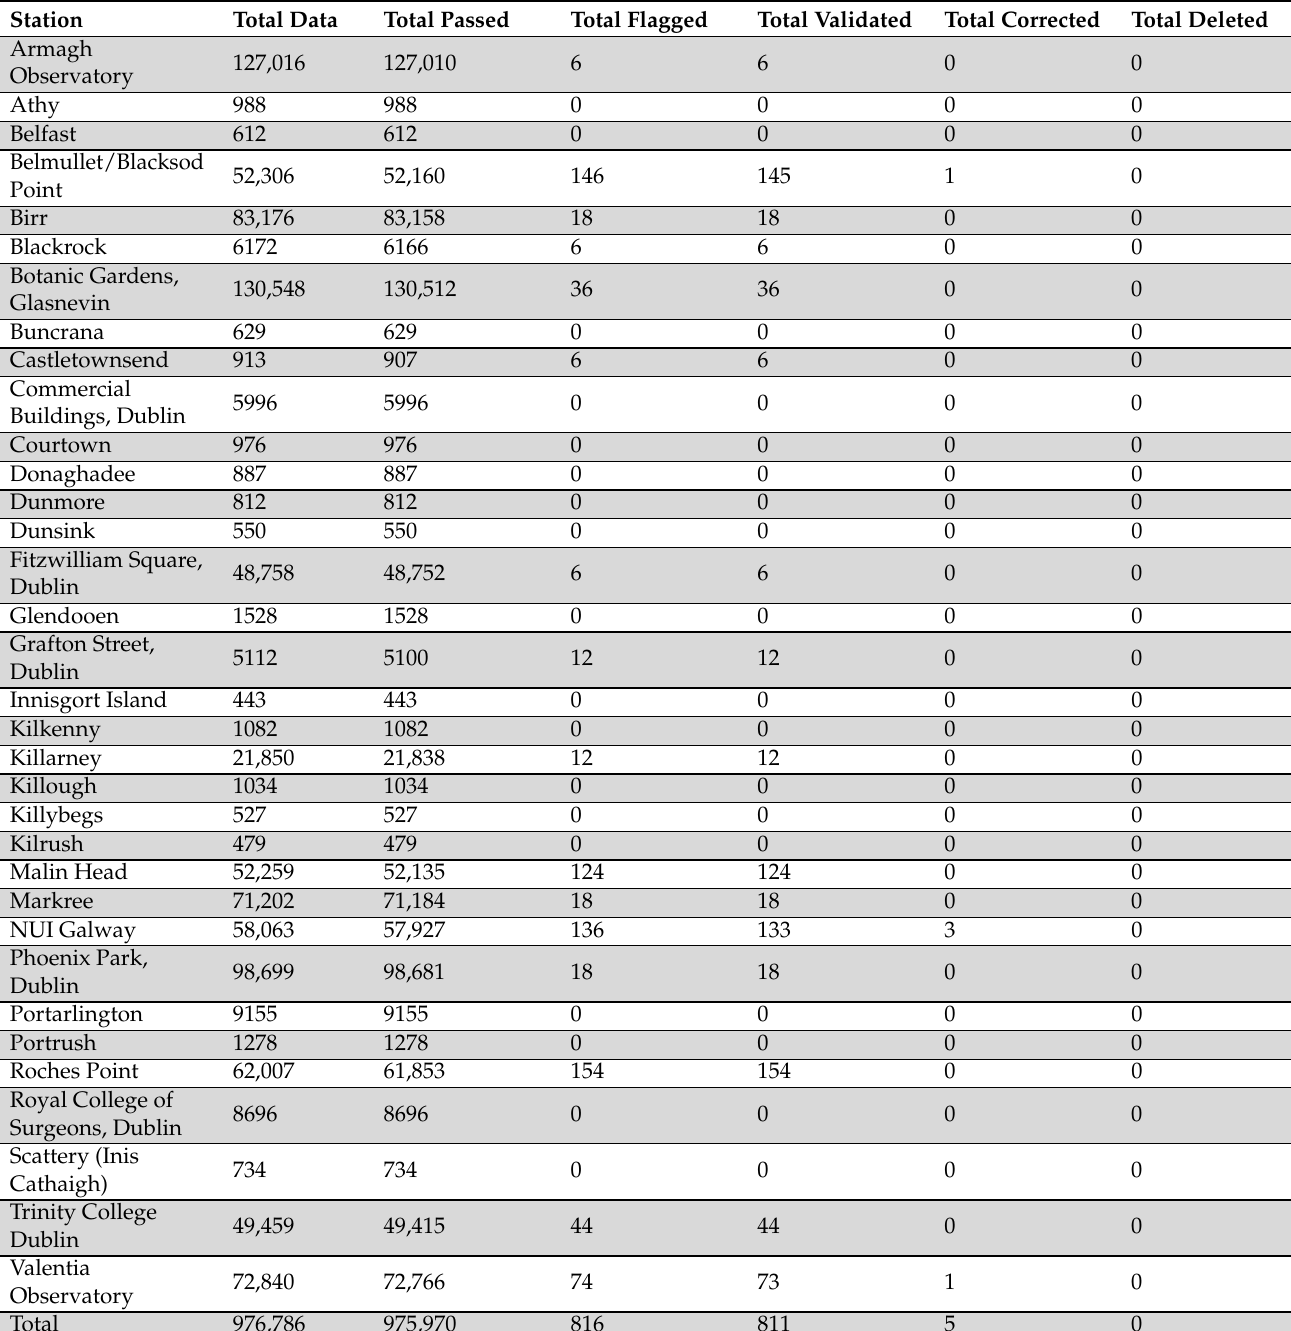
Table A10. Total of MAX and MIN data that failed the quality control test flag 11 and total validated, corrected and deleted